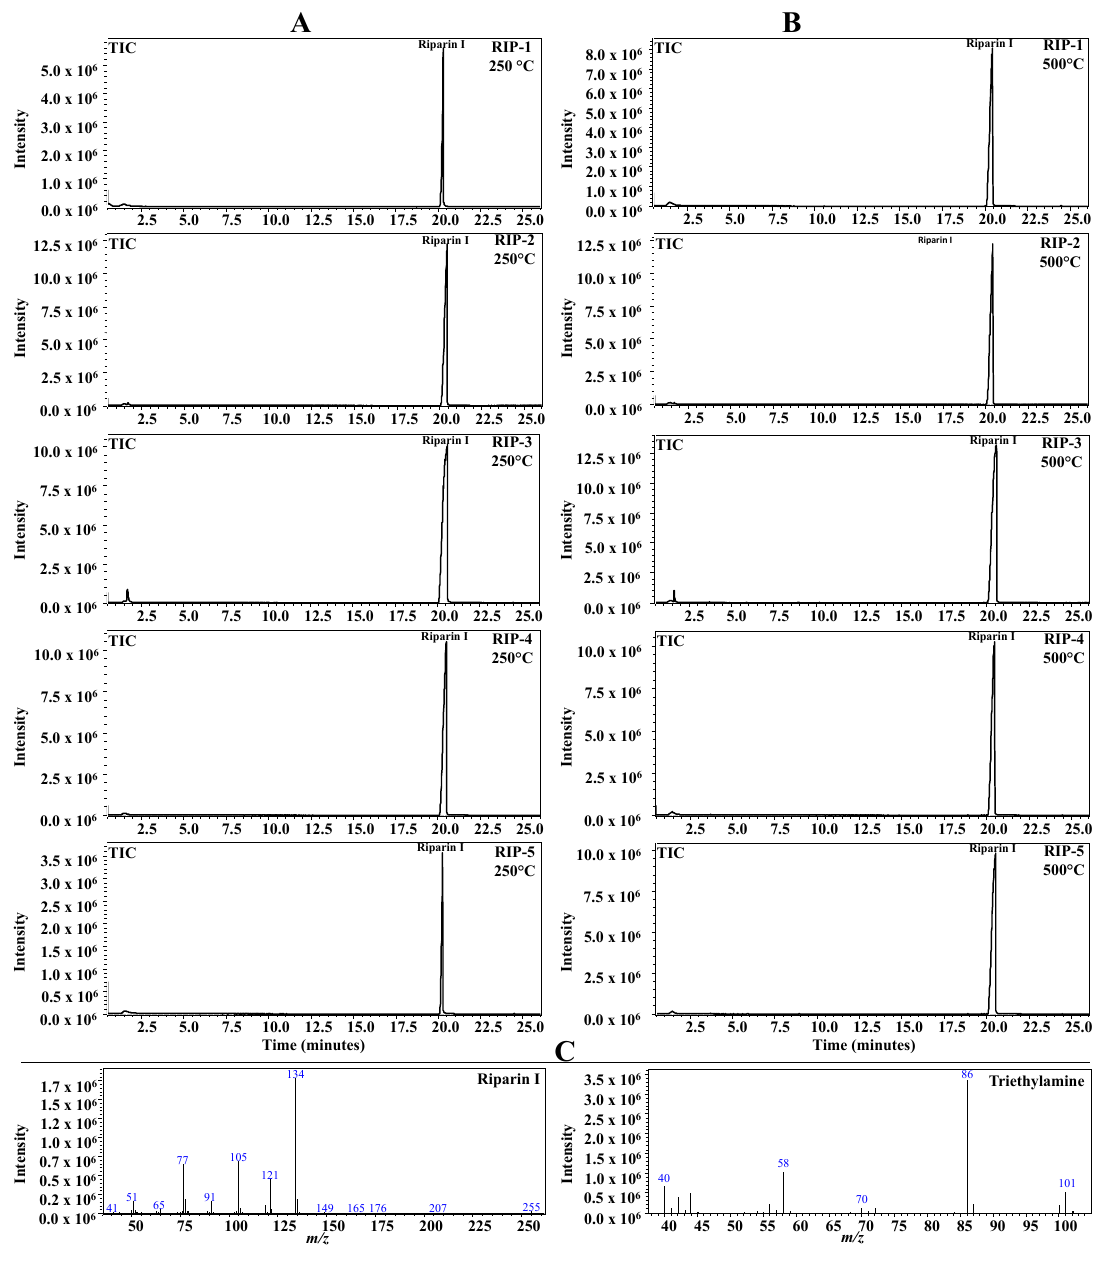
Figure 6. Pyrograms obtained from riparin at the temperatures of 250.0 °C (column ( A )) and 500.0 °C (column ( B )), showing the peak corresponding to riparin I and the product ion mass spectra of riparin I and triethylamine (column ( C )—bottom of the figure).